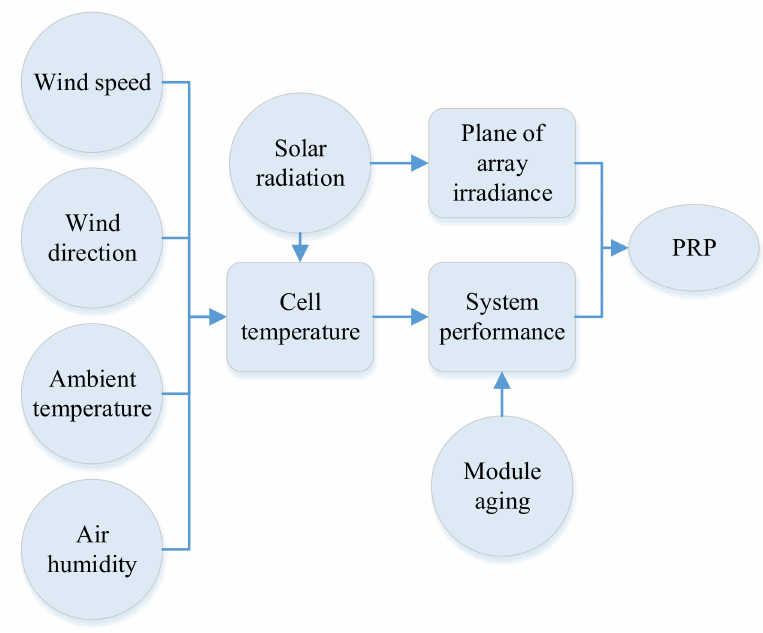
Figure 1. The essential influences on the